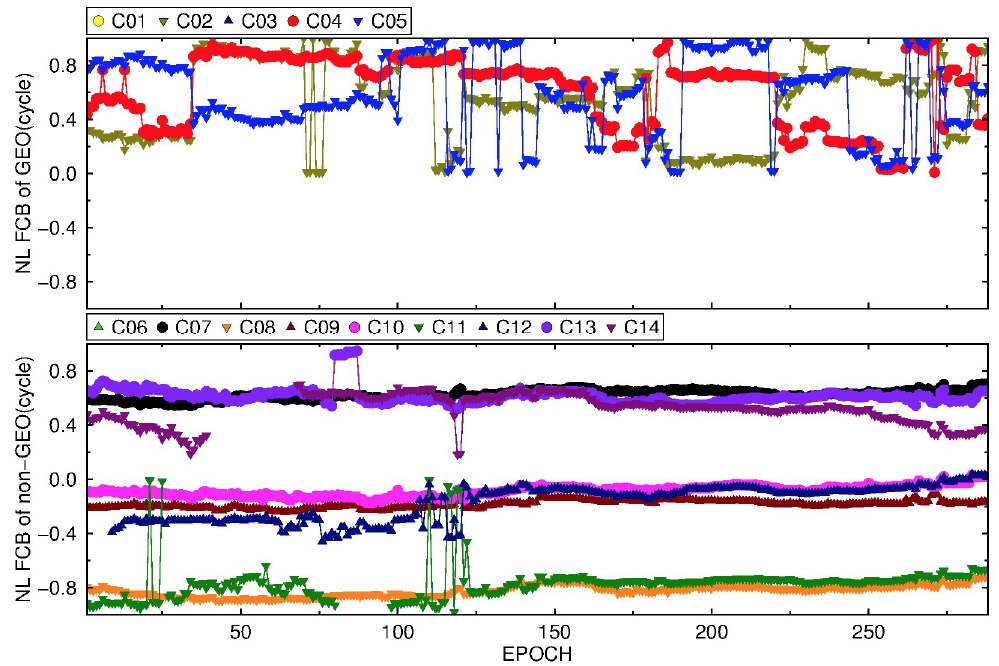
Figure 13. The variation of BDS NL FCB by the traditional strategy on DOY 083, 2018.